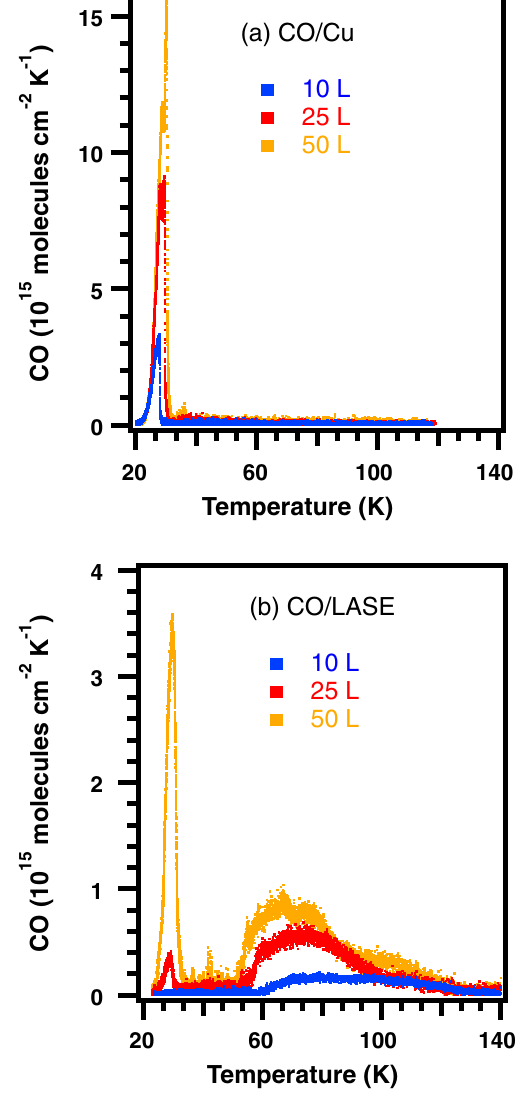
FIG. 5. TPD curves as a function of CO dose on flat poly-Cu substrate (a); LASE-Cu sample (b).